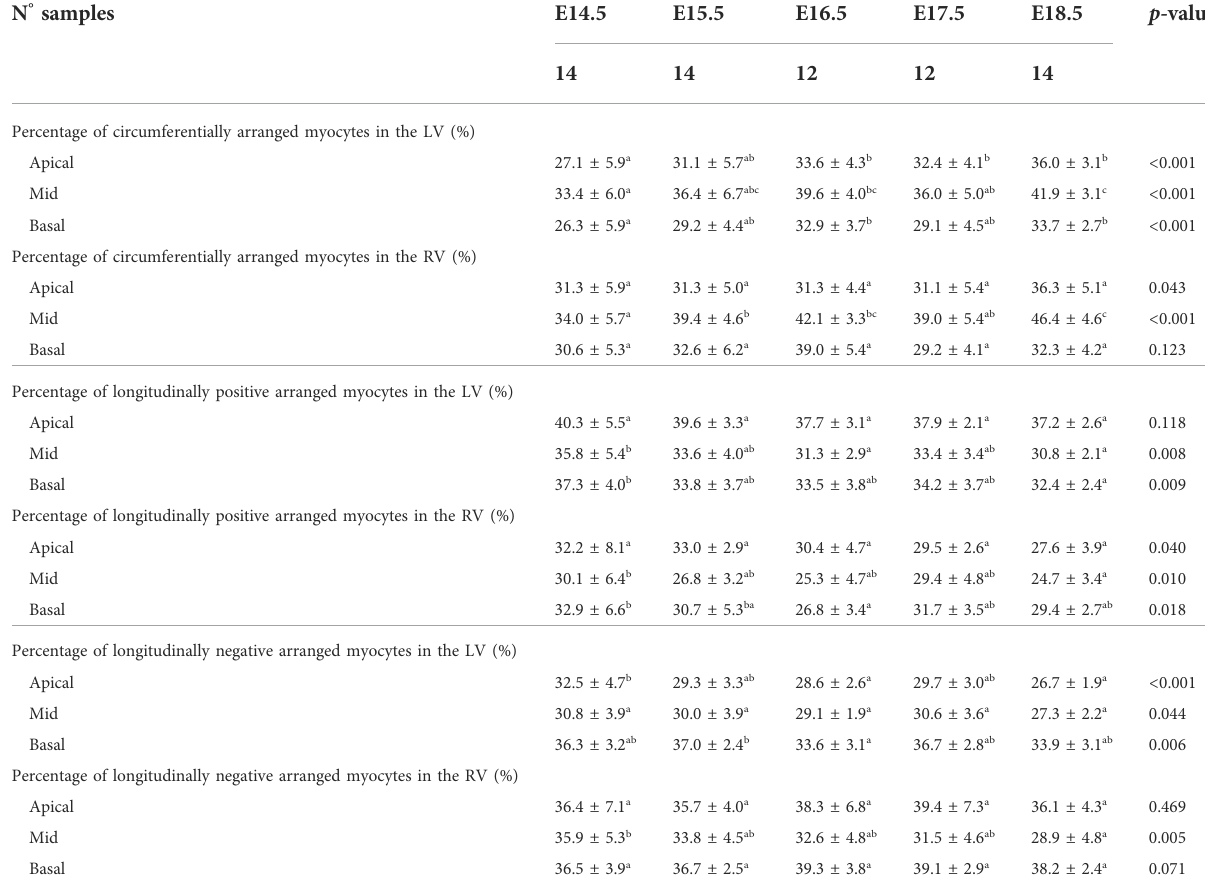
TABLE 1 Percentage of circumferentially ( − 20 ° < HA < 20 ° ), longitudinal positive (HA > 20 ° ) and longitudinal negative (HA < − 20 ° ) arranged myocytes within the left (LV) and right ventricle (RV), expressed as mean ± standard deviation. N °